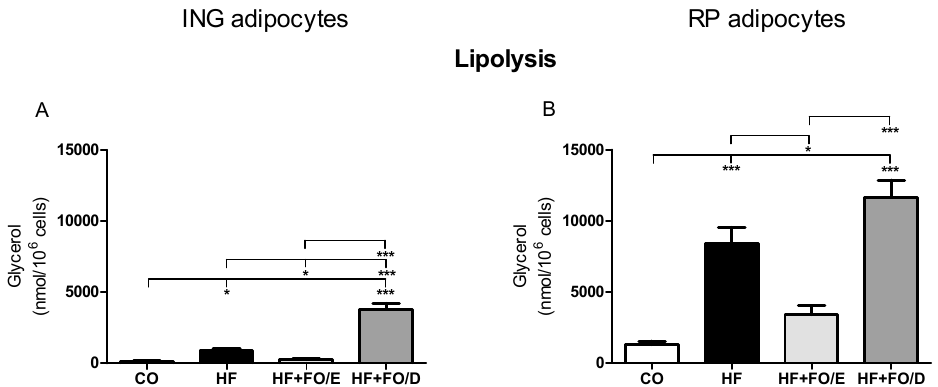
Figure 5. Lipolysis in isolated adipocytes from ING and RP fat depots. ( A ) glycerol released from ING adipocytes, ( B ) glycerol released from RP adipocytes. FO: fish oil; CO: control diet; HF: hifh fat diet; HF+FO/E, HF diet supplemented with FO containing high concentration of EPA; HF+FO/D, HF diet supplemented with FO containing high concentration of DHA; ING: inguinal; RP: retroperitoneal. Mean ± SEM. * p < 0.05, *** p <